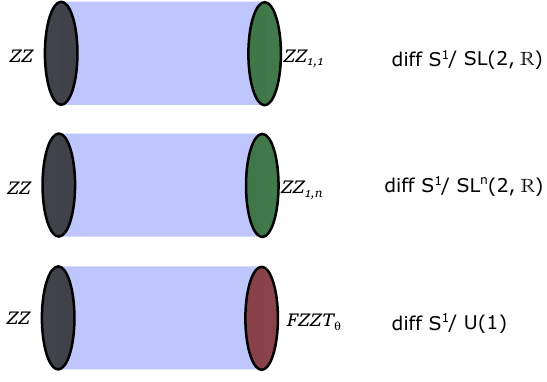
Figure 14 . Other brane con(cid:12)gurations. Top: the ZZ-ZZ system. Middle: the ZZ-ZZ 1 ;n system. Bottom: the ZZ-FZZT